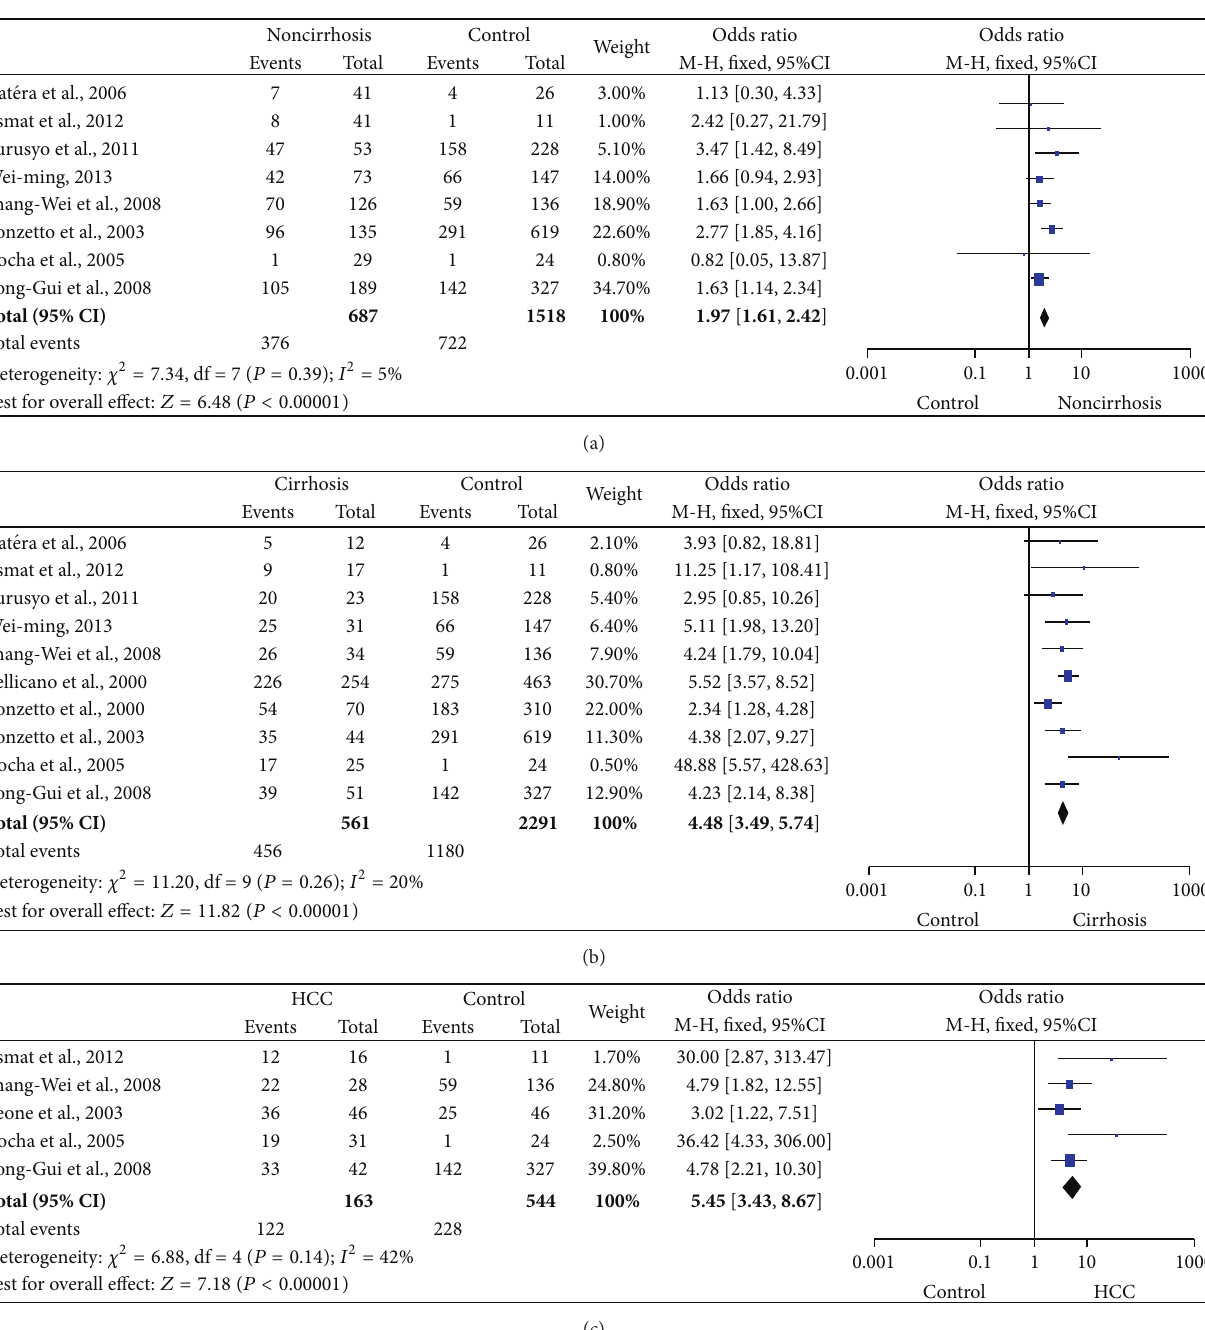
that the histopathological changes were more severe in patients with H. pylori positive HCV than in patients with HCV alone [29]. Furthermore, Umemura et al. demonstrated that the eradication of H. pylori could increase sustained virological responses in patients with CHC [30]. Moreover, many studies conducted in vitro demonstrated a cytopathic effect of H. pylori on hepatocytes [31, 32]. Therefore, our results are consistent with the above